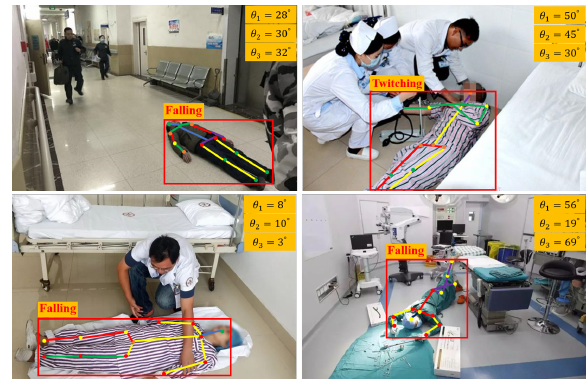
Fig. 8. Examples of abnormal behavior detection and assistance for different